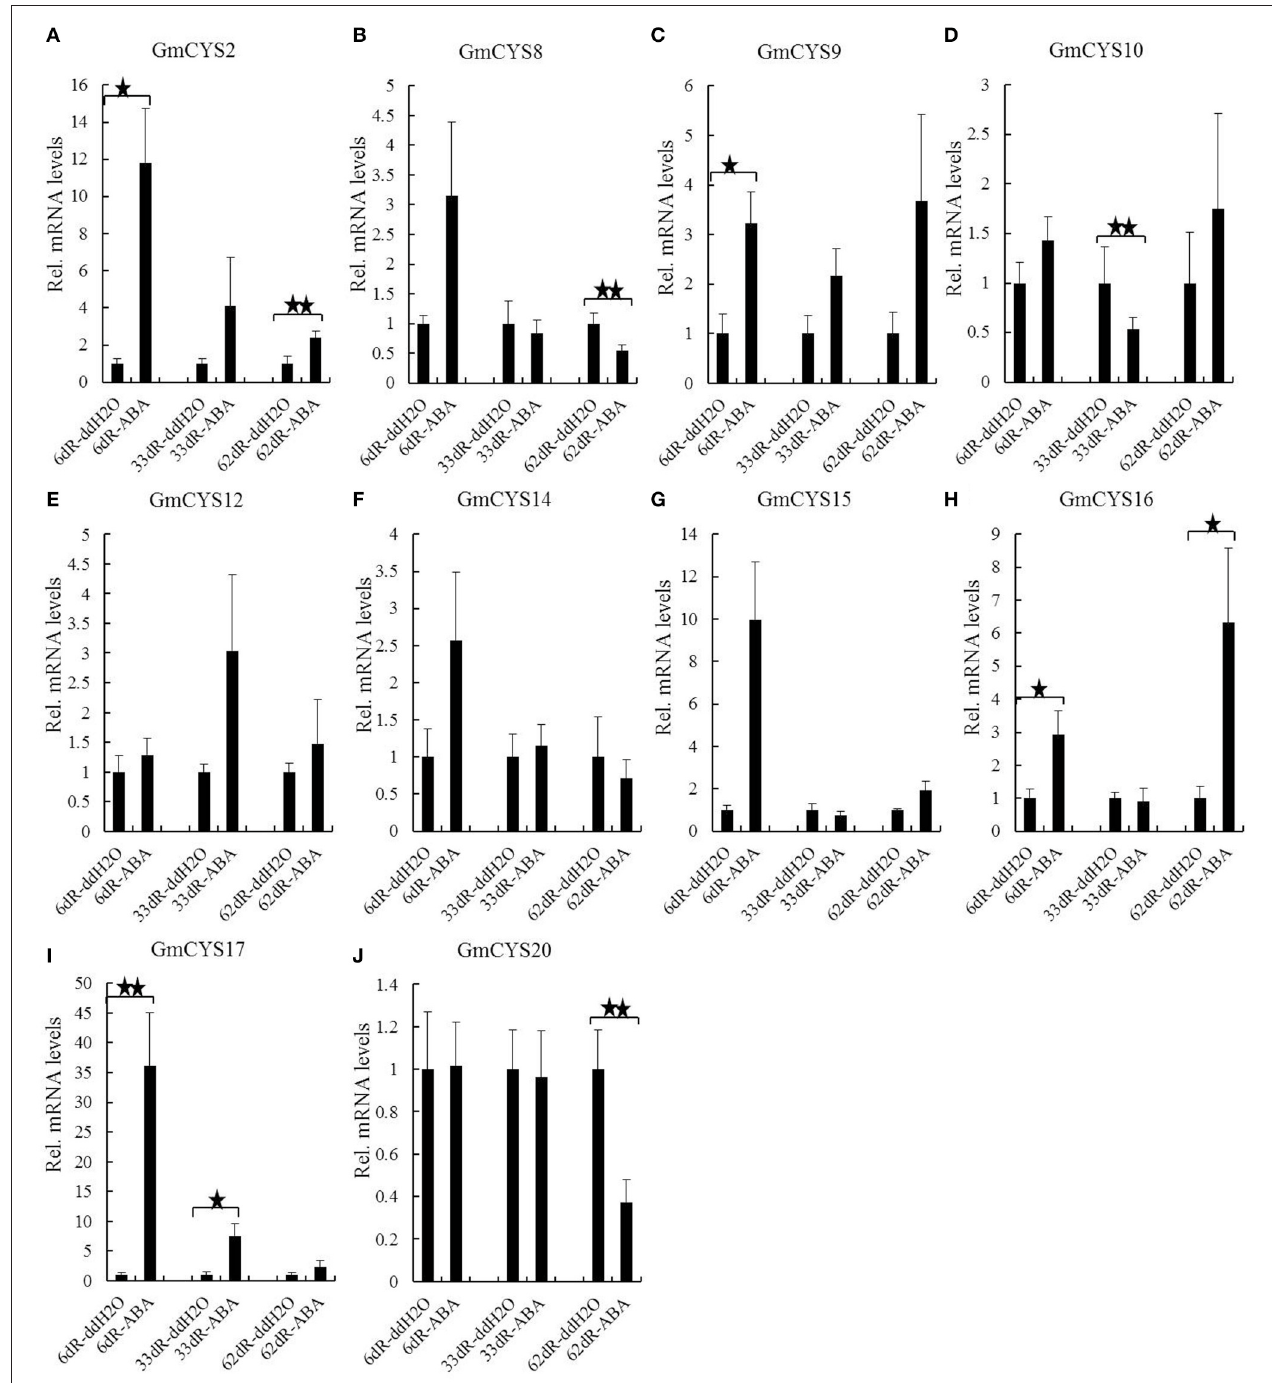
FIGURE 6 | Expression profile of soybean cystatin genes in response to ABA treatment in symbiosis with B. japonicum strain 113-2. Three biological replica samples and three replicate reactions per sample were used to calculate the expression level of 10 cystatins in inoculated roots (with nodules, ddH 2 O, and ABA treatment) at 6, 33, and 62 days of post inoculation. Relative expression levels of each cystatin gene were obtained by qPCR and normalized to the average expression level of soybean reference gene QACT, and calculated using the expression level in ddH 2 O treatment samples as controls. Data are presented as mean ± SE of nine independent replicate experiments. “ ⋆ ”and “ ⋆⋆ ” indicate statistical difference between different treatment inoculated roots ( t -test, p < 0.05 or p < 0.01, respectively). (A) GmCYS2. (B) GmCYS8. (C) GmCYS9. (D) GmCYS10. (E) GmCYS12. (F) GmCYS14. (G) GmCYS15. (H) GmCYS16. (I) GmCYS17. (J) GmCYS20.